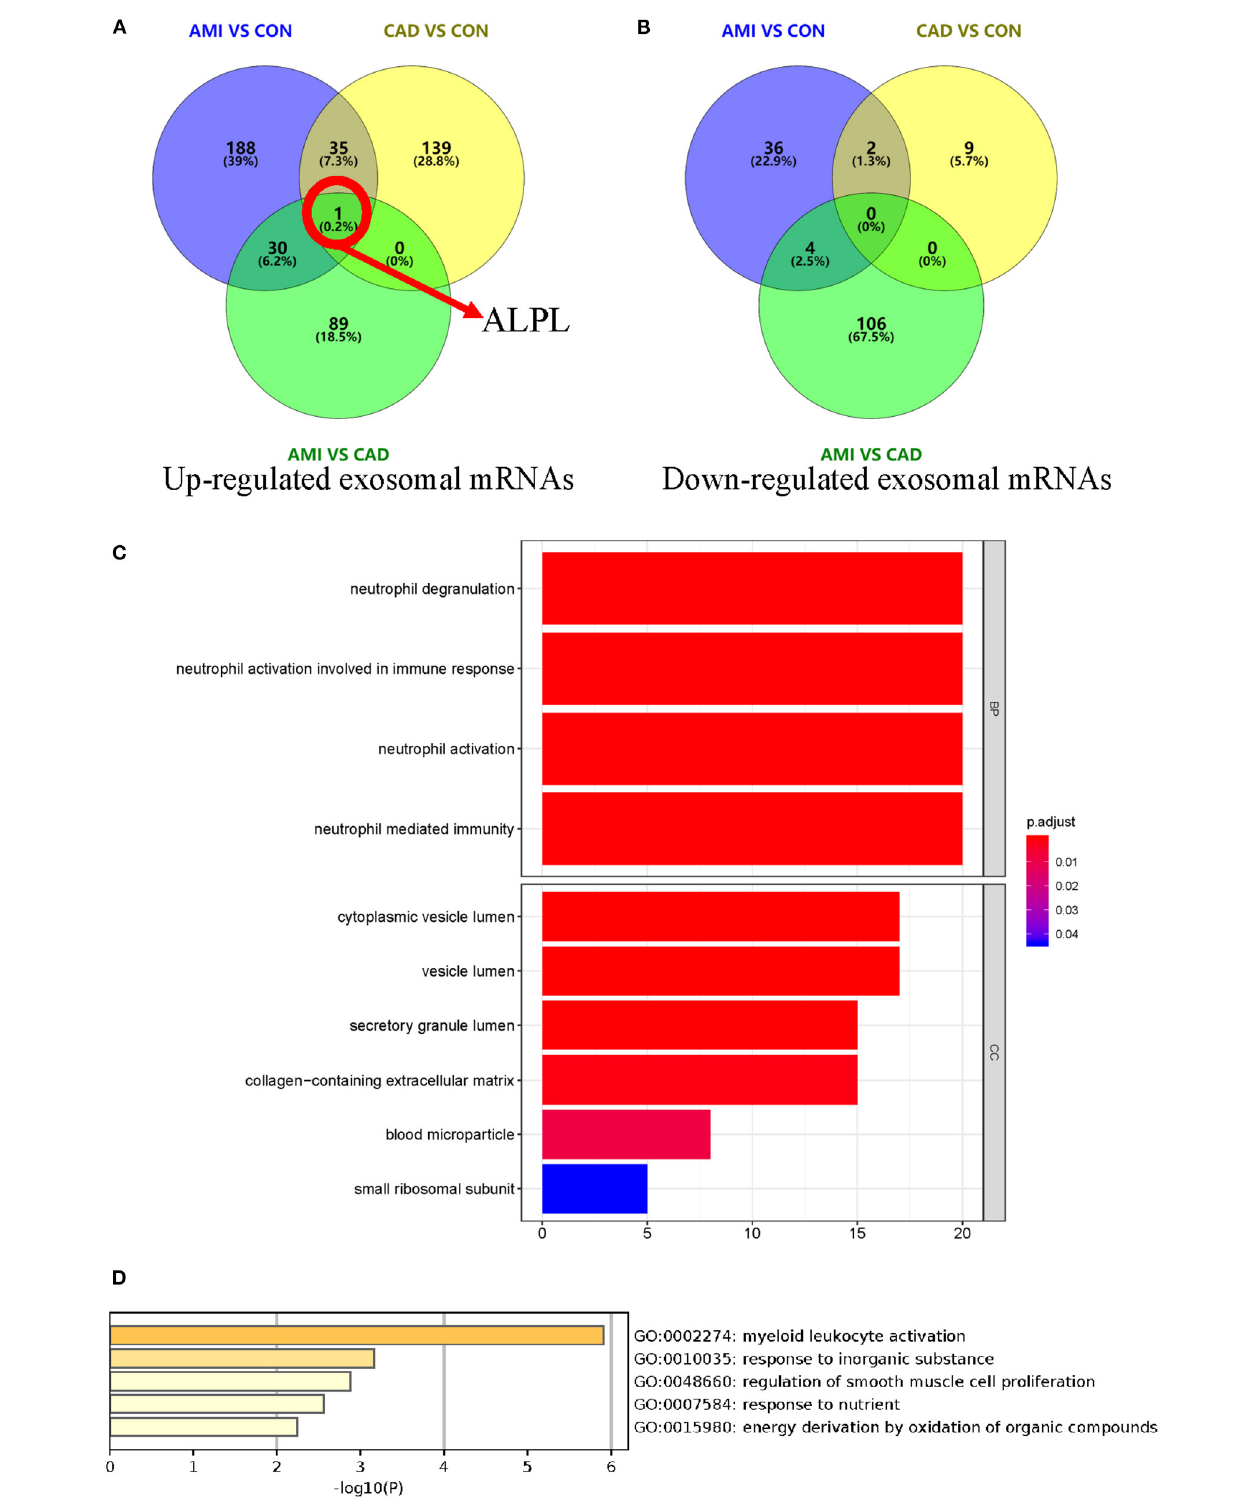
FIGURE 4 | Identification of different exosomal long RNAs and functional enrichment analysis between AMI and CAD. (A,B) Comparation of differently up- or down-regulated exosomal mRNAs between AMI and control, AMI and CAD, and CAD and control. These three comparison sets were intersected with each other. (C) Functional enrichment analysis of significantly different exosomal mRNA between AMI and CAD. (D) Gene ontology analysis result of 35 different exosomal mRNAs between the comparison of AMI and control and comparison of AMI and CAD.